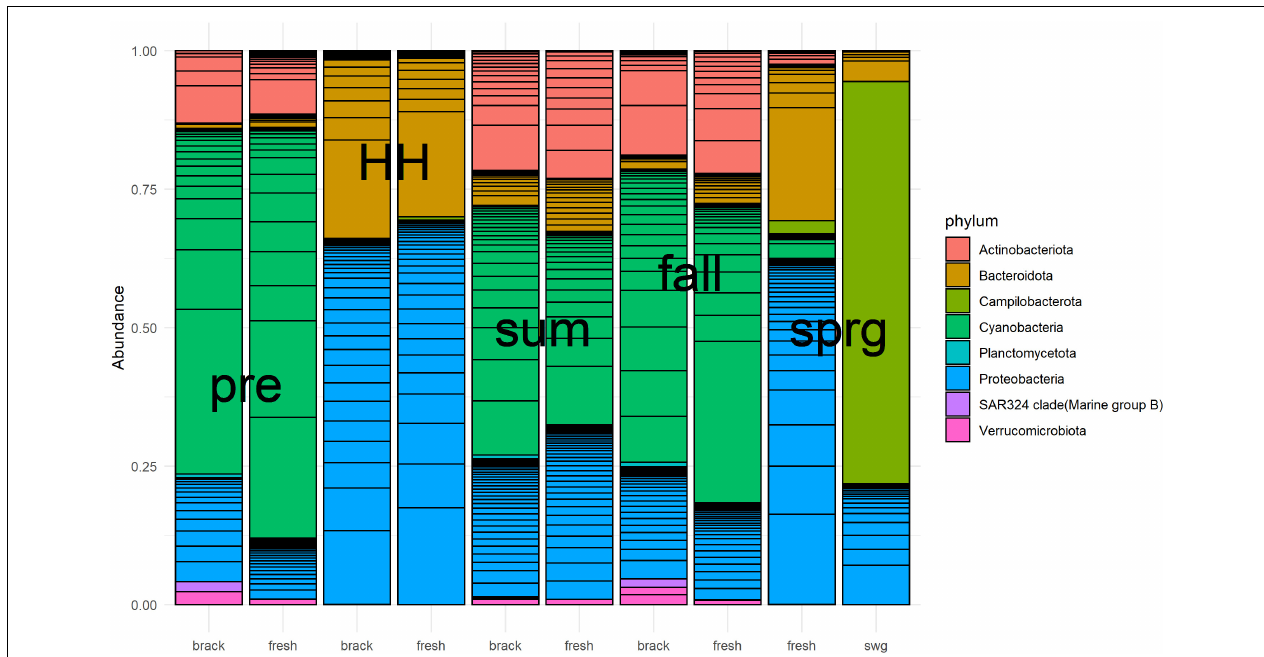
FIGURE 7 | Relative abundance of numerically dominant microbes in Clear Lake for samples collected from August 2017 to March 2018. Samples were merged by baseline salinity of segment (brack: 2425 and 2425B, fresh: 1101, 1101C, and 1113B) and type [pre-HH (pre), HH, summer (sum), fall and spring (sprg)]. A sewage-spiked (swg) sample is included for comparison. The hundred most abundant ASV are shown. Figure was generated with scripts in Supplementary File 8 .